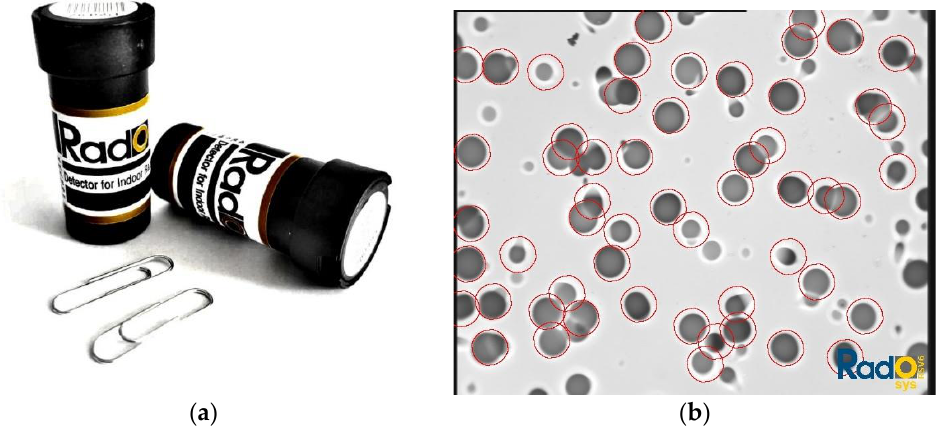
Figure 3. ( a ) Solid-state track detector RadoSys used in our work; ( b ) CR-39 foil (an example of damages after exposition).